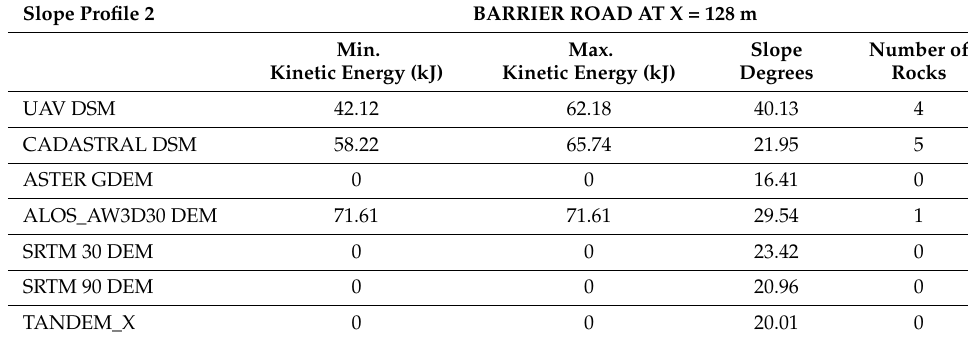
Table 7. Total kinetic energy distribution at x = 130 m for the 2nd slope profile.